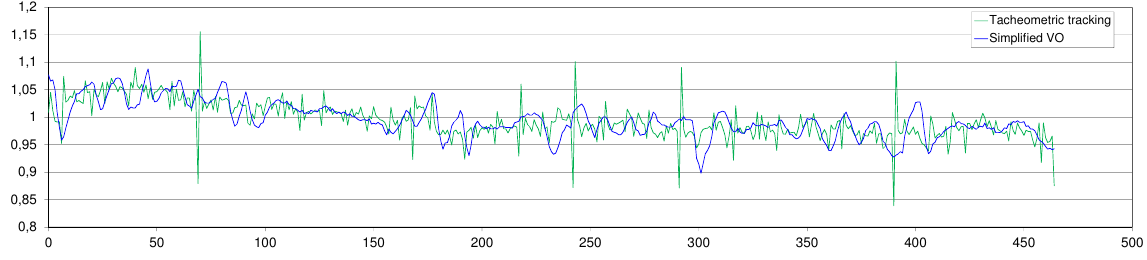
Figure 9: Inter-image distance (m) vs. curvilinear abscissa (m): comparison between tacheometric tracking and automatic simplified visual